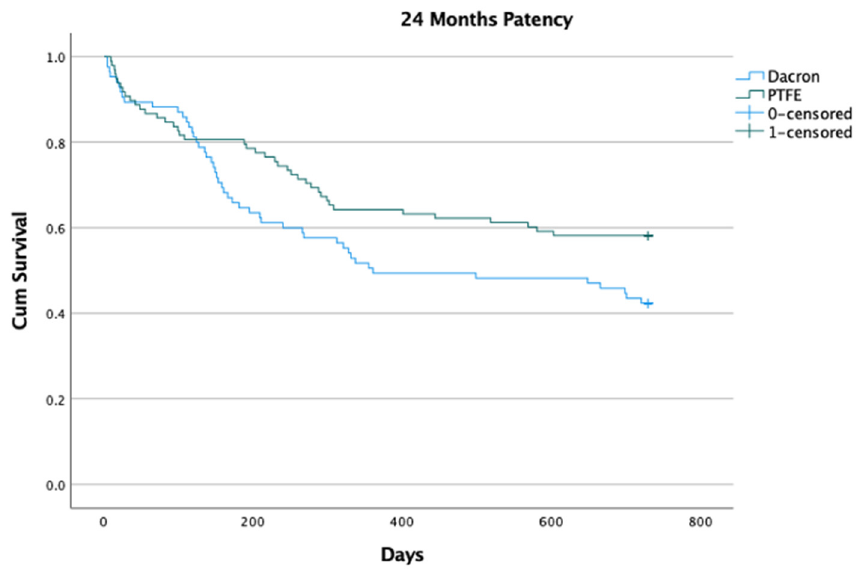
Figure 1. Kaplan–Meier 24-month patency curves for PTFE and Dacron groups in all patients ( p = 0.043).